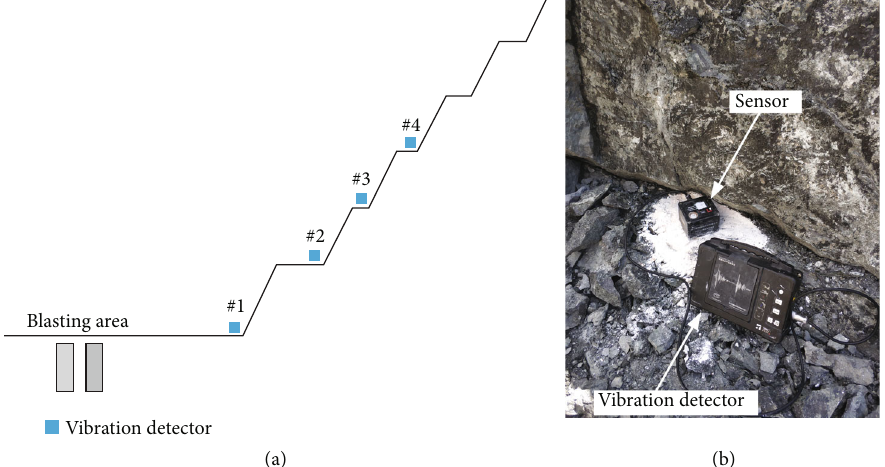
Figure 2: Schematic diagram of the relative positions of the vibration detector installation (a) and the fi eld-installed vibration detector